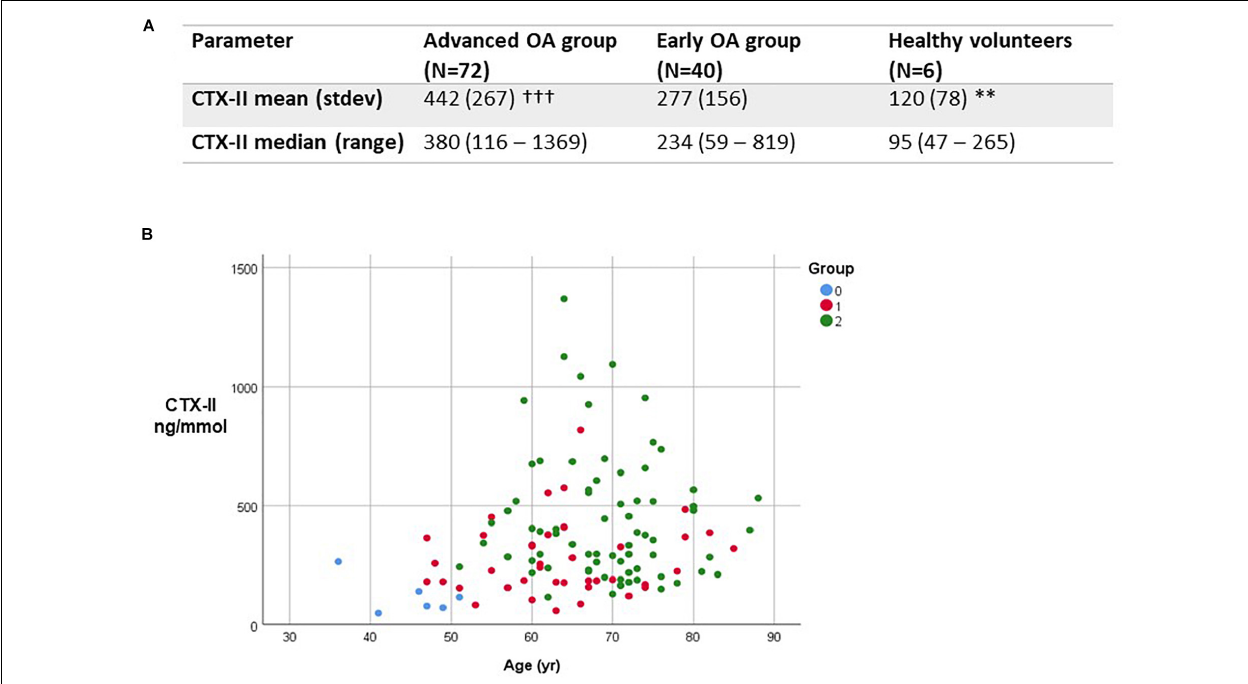
FIGURE 2 | Type II collagen degradation product expression in study. (A) Comparison between urinary CTX-II levels in study groups in ng/mmol. ∗∗ p < 0.01, between healthy controls and all OA patients; ††† p < 0.001 between advanced and early OA groups. (B) Variation in levels of CTX-II by subject group and